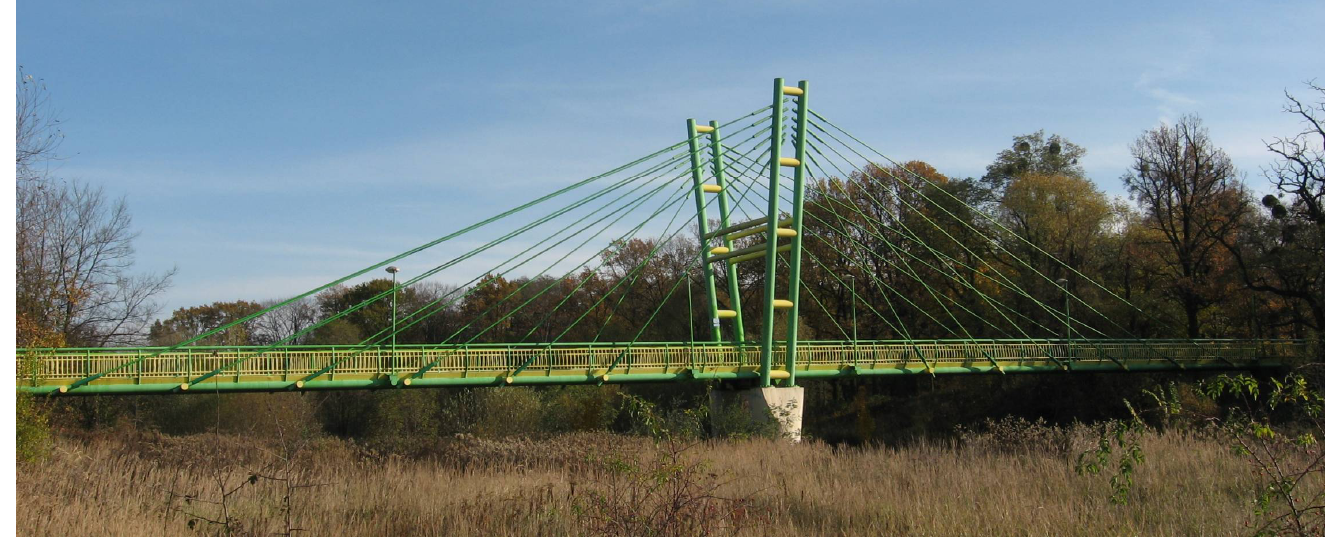
Figure 2. Panoramic view of the footbridge.